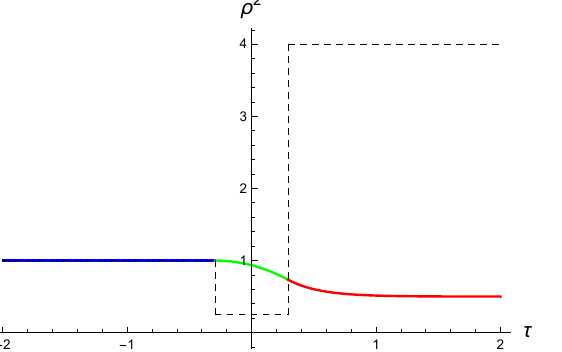
Figure 6. (cid:26) ( (cid:28) ) 2 for a (cid:12)ne-tuned dip quench with ! 0 = 1 ; ! 2 = 1 = 2 ; ! 1 = 2. The blue part of the curve corresponds to (cid:28) < (cid:0) T= 2, the green part for (cid:0) T= 2 < (cid:28) < T= 2 and the red part is (cid:28) > T= 2. The quench pro(cid:12)le is shown by dashed lines.